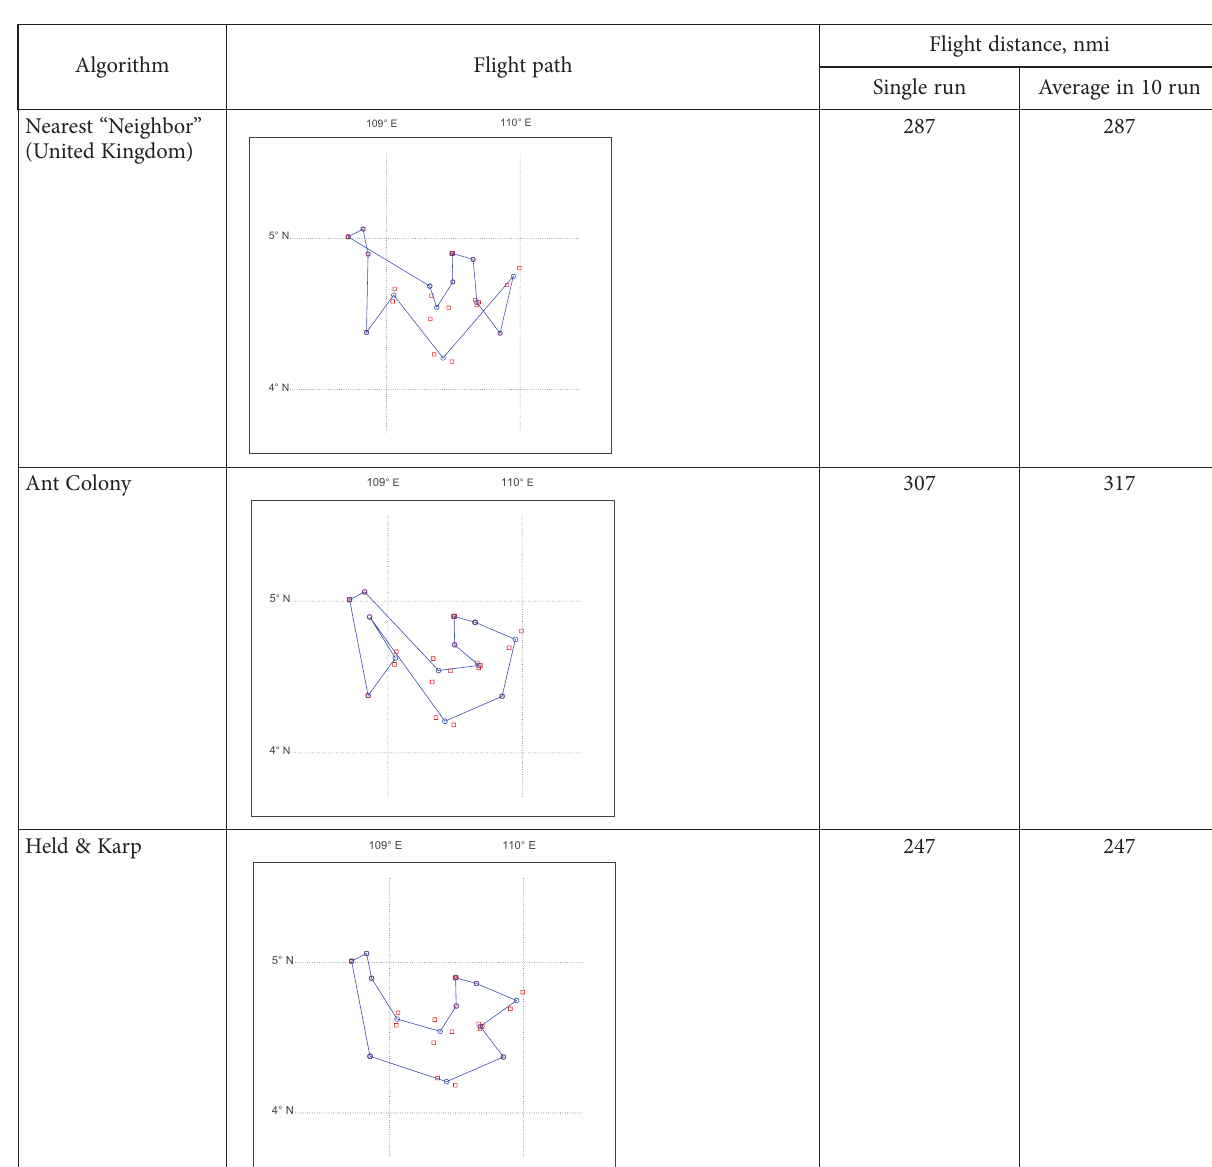
Figure 5. Nearest “Neighbour” (United Kingdom) algorithm flowchart Table 3. Comparison of clustering